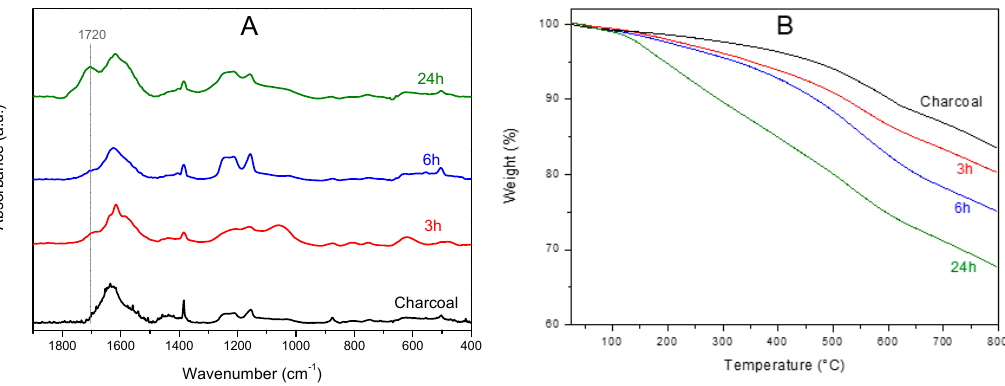
Figure 2. ( A ) FTIR spectra and ( B ) TGA scans of the used charcoal sample after different times of oxidation by H 2 O 2 at 60 °C.